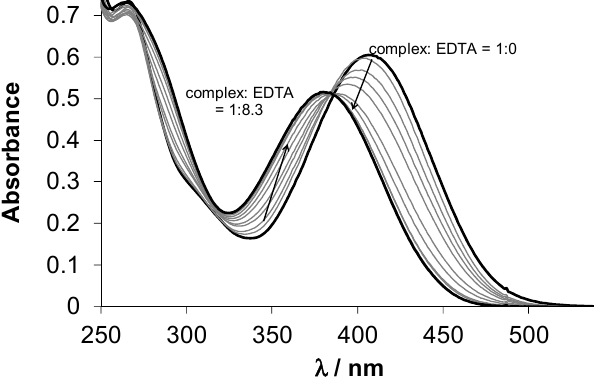
Figure 3. UV–Vis spectra of 2 in the presence of EDTA at various concentrations, and the numbers show the complex-to-EDTA ratios {c 2 = 50 µ M; c EDTA = 0–422 µ M; pH = 5.90 (50 mM MES); T = 298 K; I = 0.10 M (KCl); ℓ = 1.0 cm; 1% DMSO}.